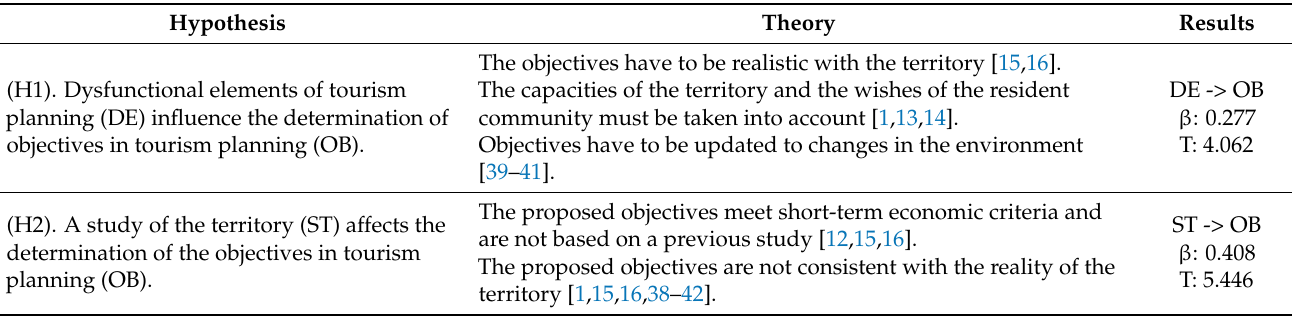
Table 9. Hypothesis, theory and